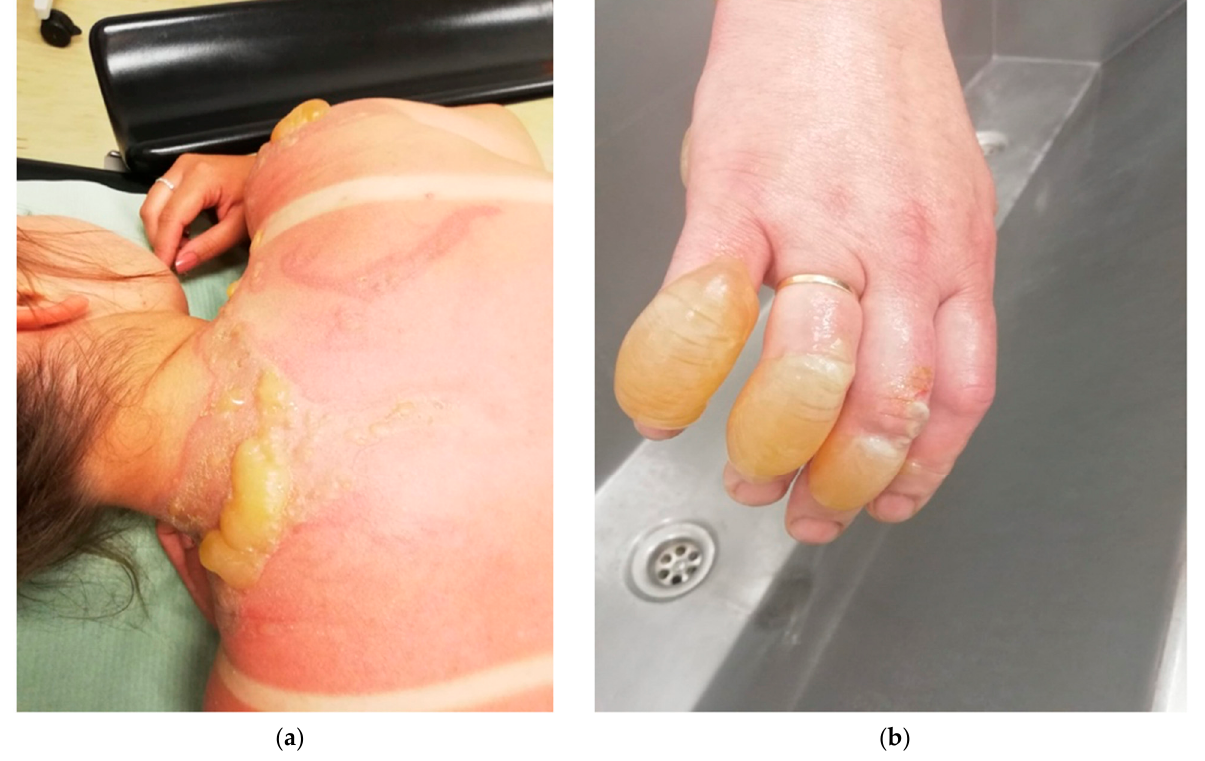
Figure 4. ( a , b ) 2nd degree burn—scalding with hot soup.